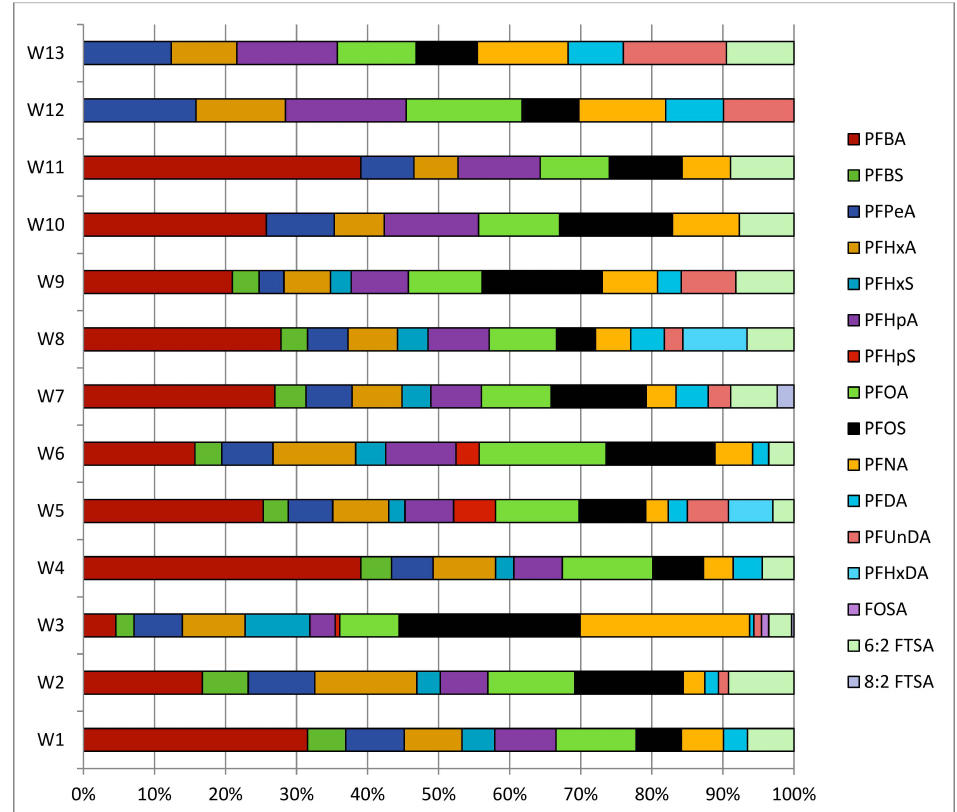
Figure 2. PFAS profiles based on mean concentrations of individual PFASs in surface water samples. Sampling sites are arranged in geographical order (from south to north), with the exception of background sites, which are presented at the top. PFASs are arranged according to ascending carbon chain length (shortest first).